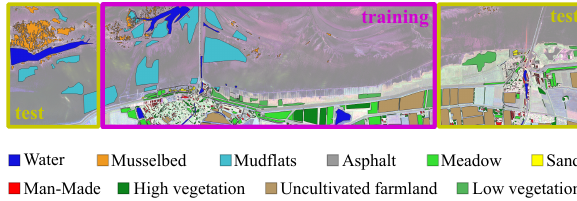
Figure 2. Manually generated reference labels for training and testing, covering ten land cover